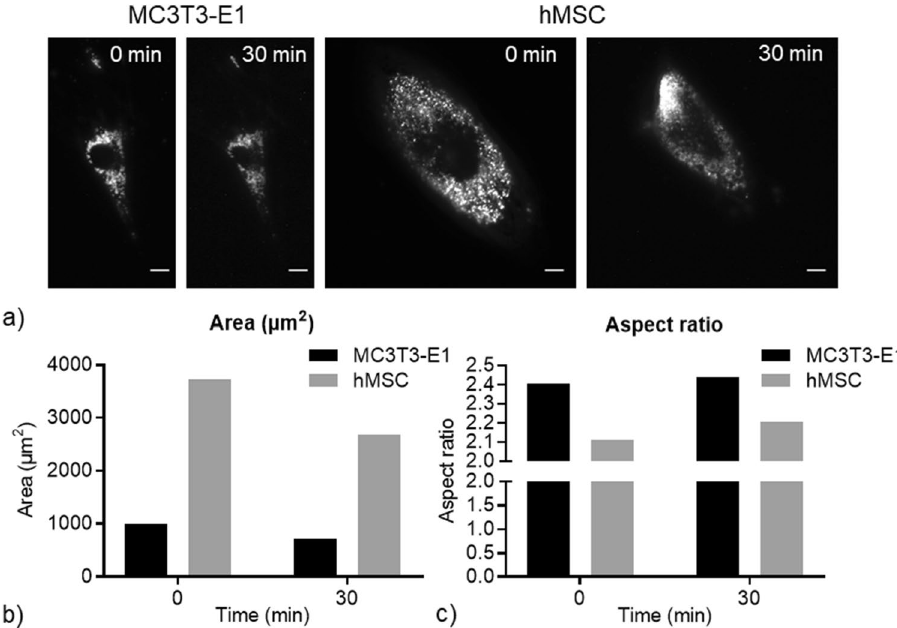
Figure 5. Cell morphology change during perfusion. ( a ) Fluorescent images of the MC3T3-E1 cell and hMSC before and after 30 min perfusion at 4 µl/min flow rate. Scale bar is 10 μm. ( b , c ) Quantification of cell morphology change including area and aspect ratio, respectively. Data shows a single cell as an